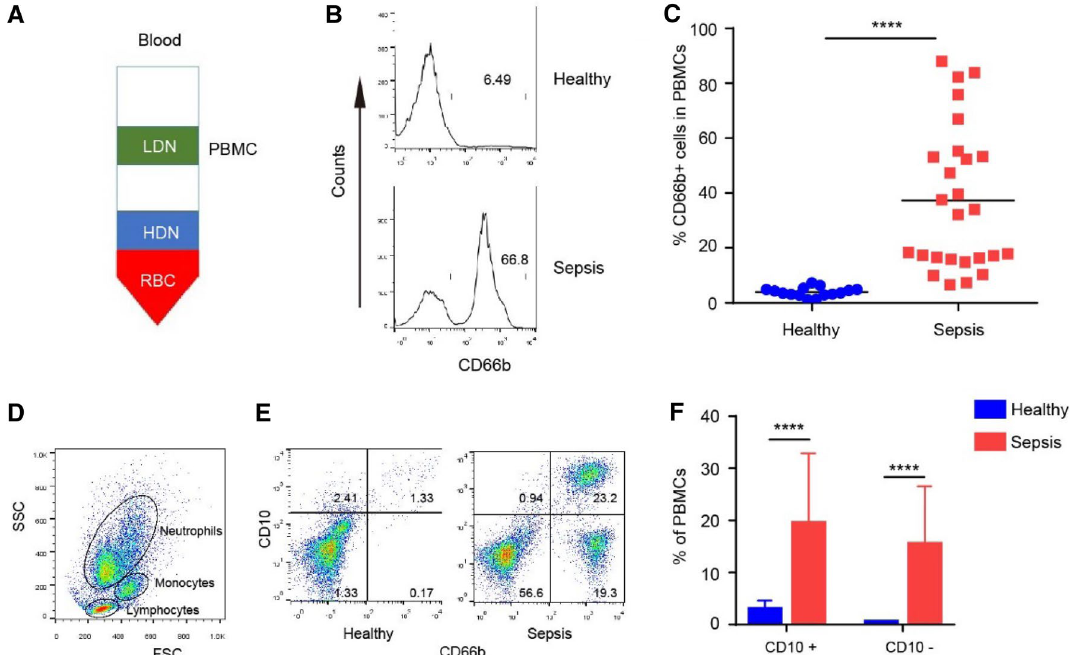
granulocytes (primarily HDNs), and erythrocytes. ( B , C ) The percentage of LDNs (CD66b + cells) in healthy volunteers and sepsis patients was analyzed using flow cytometry. ( D ) Flow cytometric gating of various cells in the PBMCs. ( E ) CD66b and CD10 were labeled simultaneously and measured using flow cytometry. ( F ) Proportion of CD10 + LDNs and CD10 - LDNs in